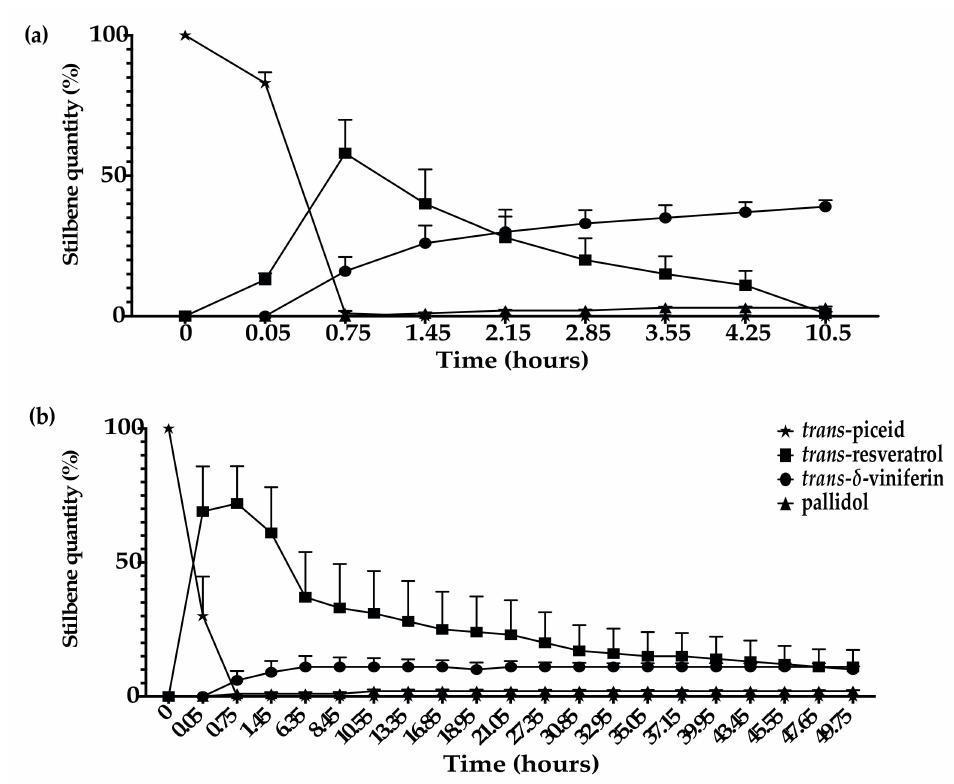
Figure 8. Kinetics of trans -piceid (5 µ g/mL) metabolization in sodium acetate buffer by total extra- cellular protein extract from ( a ) D. seriata (200 µ g/mL) and ( b ) N. parvum (1 mg/mL). Evolution of trans -piceid contents is represented by star dots, trans -resveratrol is represented by square dots, trans - δ -viniferin is represented by circle dots, and pallidol is represented by triangle dots. Error bars represent the standard error of the mean (SEM). Mean and SEM were calculated over three biological replicates each comprising two technical replicates ( n = 6).